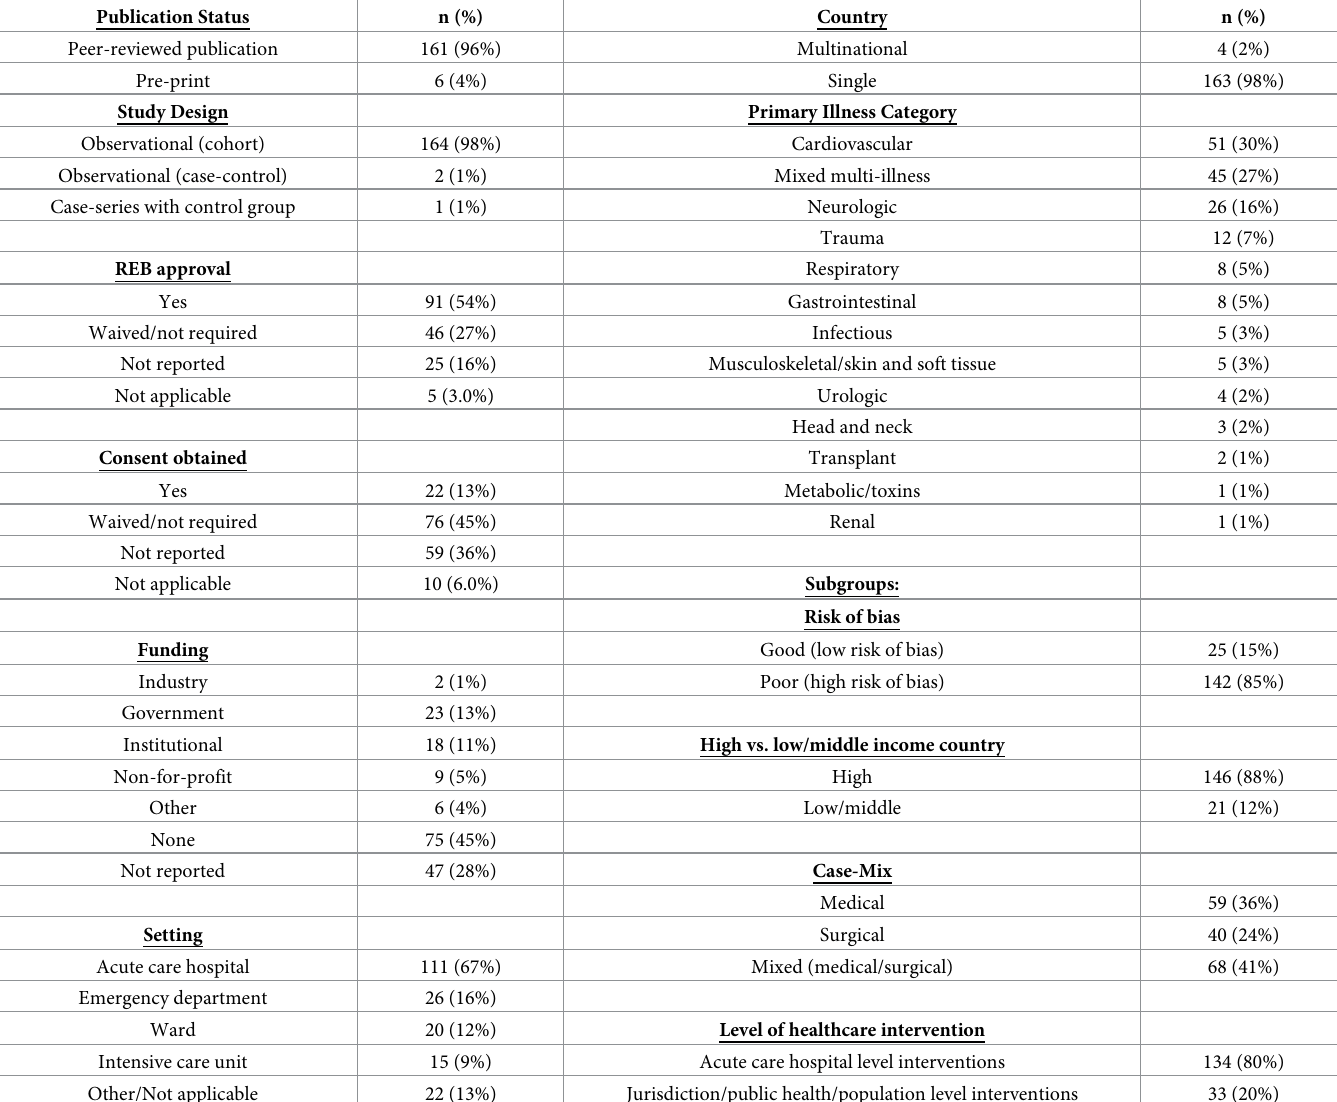
Table 1. Summary statistics of study design and characteristics for COPES Non-COVID illness during COVID pandemic (n =